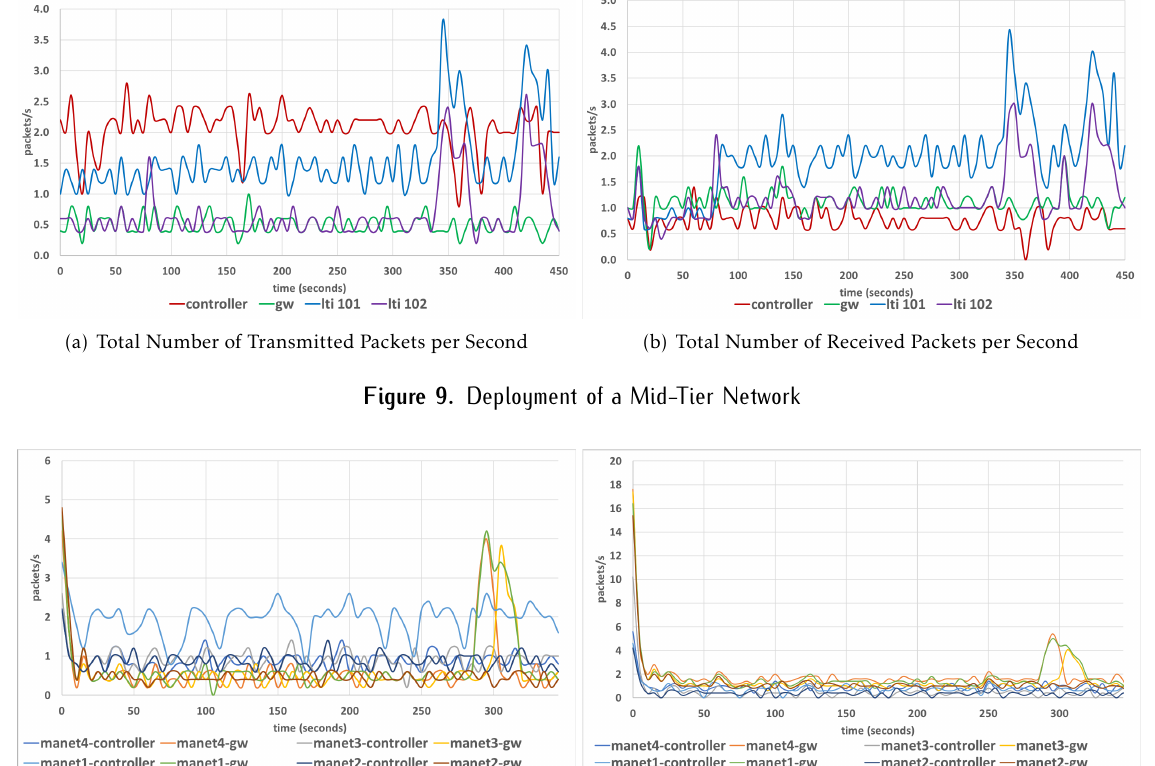
Figure 10. Deployment of a Hierarchical Heterogeneous